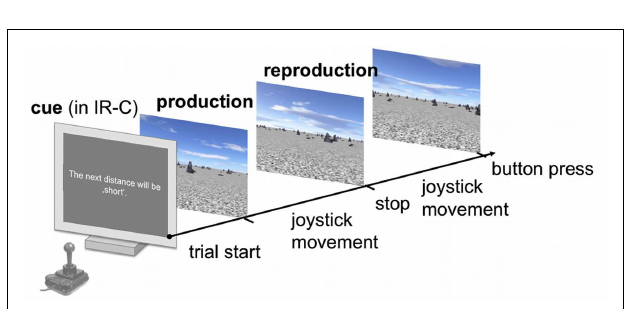
FIGURE 2 | Schematic time course of a single trial. Subjects had to subsequently produce and reproduce a sample distance in a virtual reality using the joystick to change their position with a constant speed.The final position was indicated via button press. In the IR-C condition each production-reproduction block was preceded by a symbolic cue that declared the upcoming sample displacement to be either “short” or “long.” No symbolic cue was displayed in the IR-NC and BR-NC